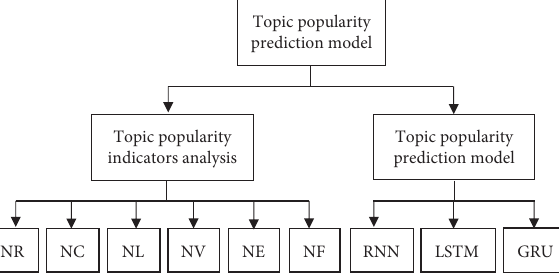
Figure 5: Topic popularity prediction